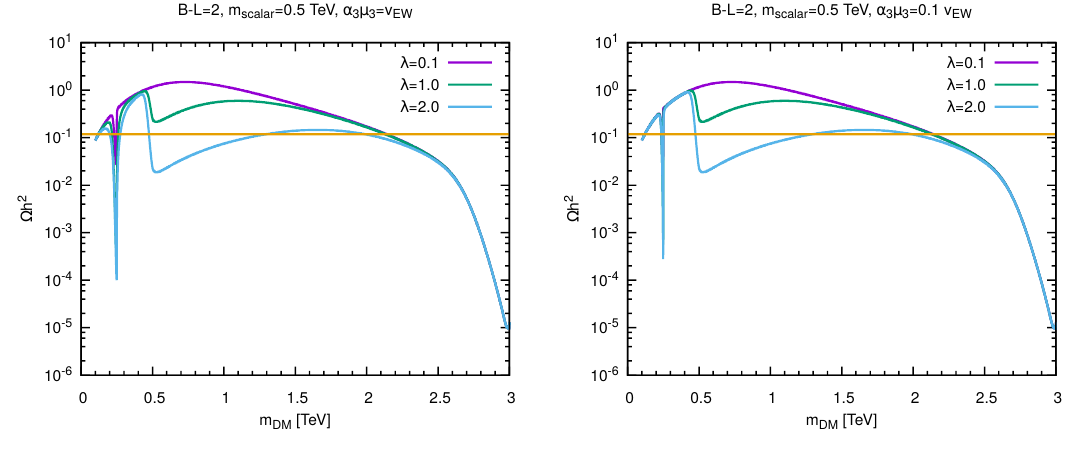
Figure 3 . Relic density as a function of the dark matter mass for B-L=2 case with M W M Z = 7 : 14 R